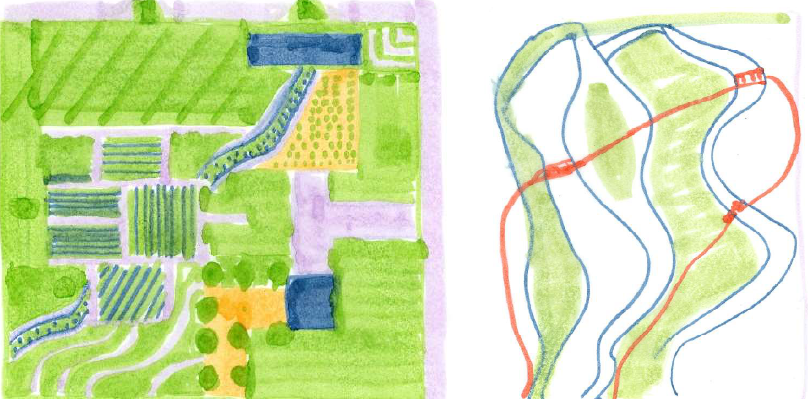
Figure 4. Previous work by the author has included working with predominantly African American communities to understand their associations with urban public spaces prior to